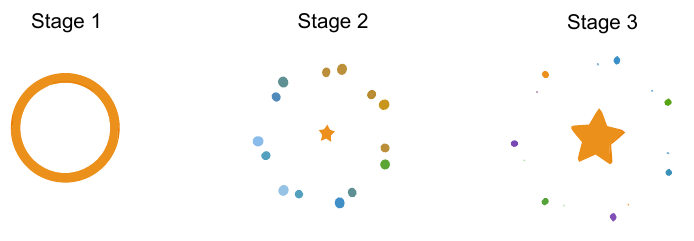
Figure 1. Three primary stages of the Lottie animation.